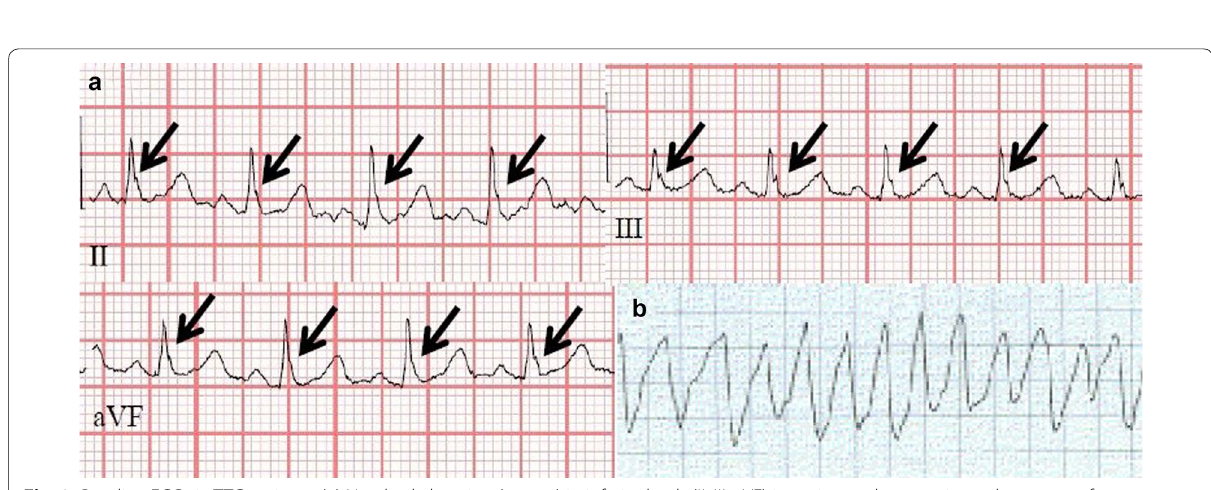
Fig. 2 Baseline ECGs in TTC patients. ( a ) Notched elevation (arrows) in inferior leads (II, III, aVF) in patients who experienced an event of polymorphic ventricular tachycardia ( b